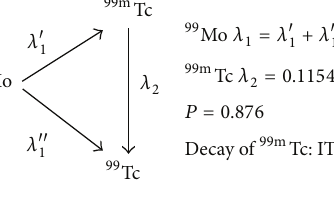
Figure 1: Simplified decay scheme of 99 Mo to 99 g